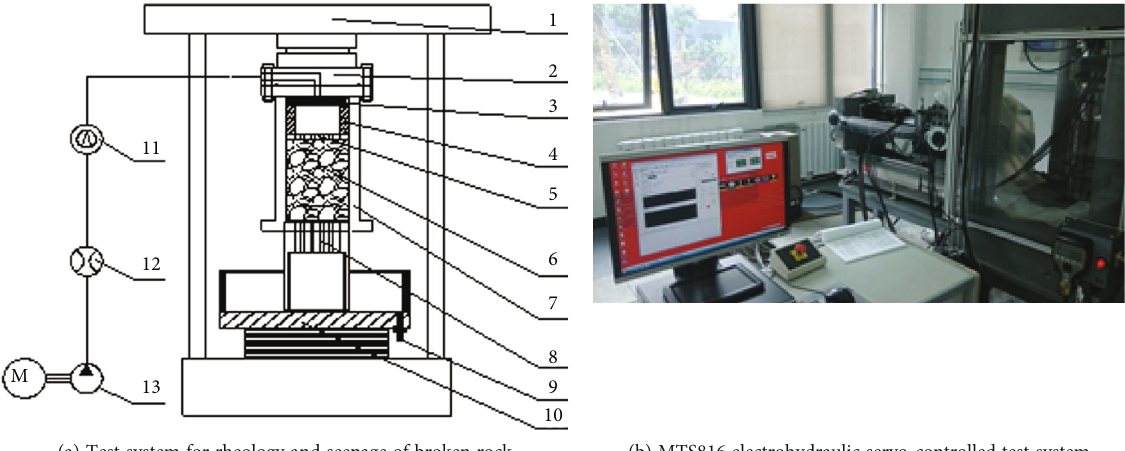
Figure 1: Test equipment. 1: MTS816; 2: permeameter base; 3: upper permeable plate; 4: pressure-bearing ring; 5: lower permeable plate; 6: broken rock; 7: permeameter sleeve; 8: piston; 9: tray outlet; 10: water-sand collection tray; 11: pressure gauge; 12: fl owmeter; 13: speed regulation